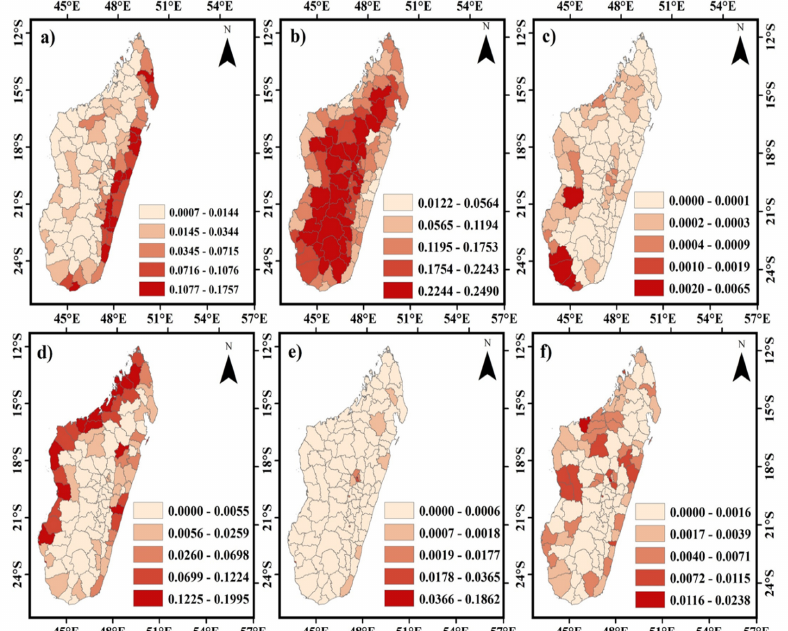
Figure 7. Spatial pattern of sensitivity coefficients of different land-use types of towns in Madagascar island in 2019. Important factors were ( a ) the spatial pattern of the sensitivity coefficient of cultivated land; ( b ) the spatial pattern of the sensitivity coefficient of forestland; ( c ) the spatial pattern of the sensitivity coefficient of the savannah; ( d ) the spatial pattern of the sensitivity coefficient of wetland; ( e ) the spatial pattern of the sensitivity coefficient of built up; ( f ) the spatial pattern of the sensitivity coefficient of water.